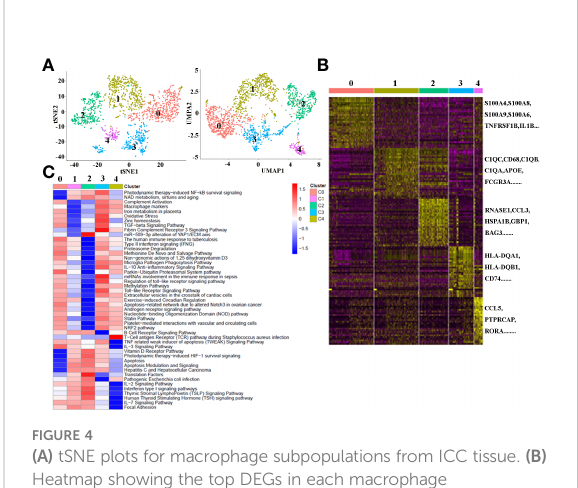
FIGURE 4 (A) tSNE plots for macrophage subpopulations from ICC tissue. (B) Heatmap showing the top DEGs in each macrophage subpopulation. (C) Differences in pathway activity (scored per cell by GSVA) in fi ve macrophage cell subclusters in tumor tissue.